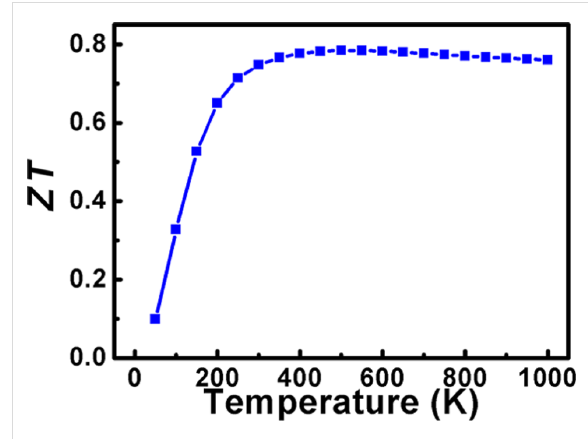
Figure 10: Figure of merit of the cubic π -SnSe as a function of temper-